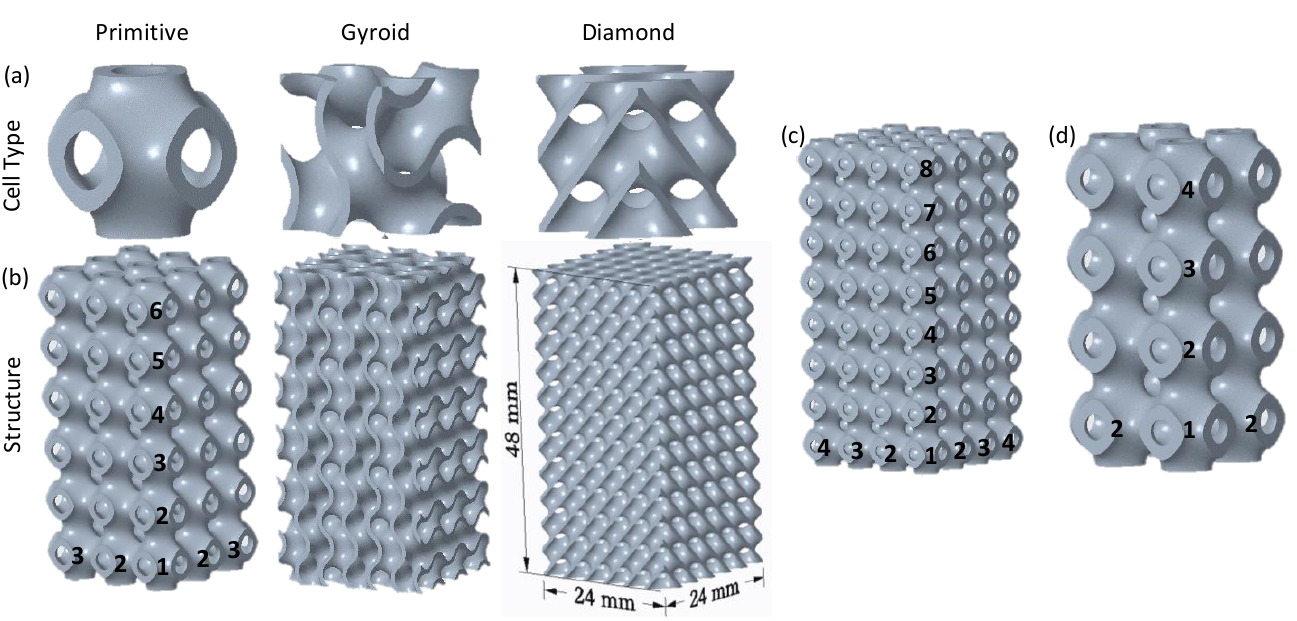
Figure 1. TPMS design: ( a ) unit cell types, ( b ) lattice structures and dimensions, ( c ) Primitive structure with 6 mm cell size (4 × 4 × 8 cells), and ( d ) Primitive structure with 12 mm cell size (2 × 2 × 4 cells). The numbers on the designs represent the number of unit cells that occupied the corresponding design along the x, y, and z directions.